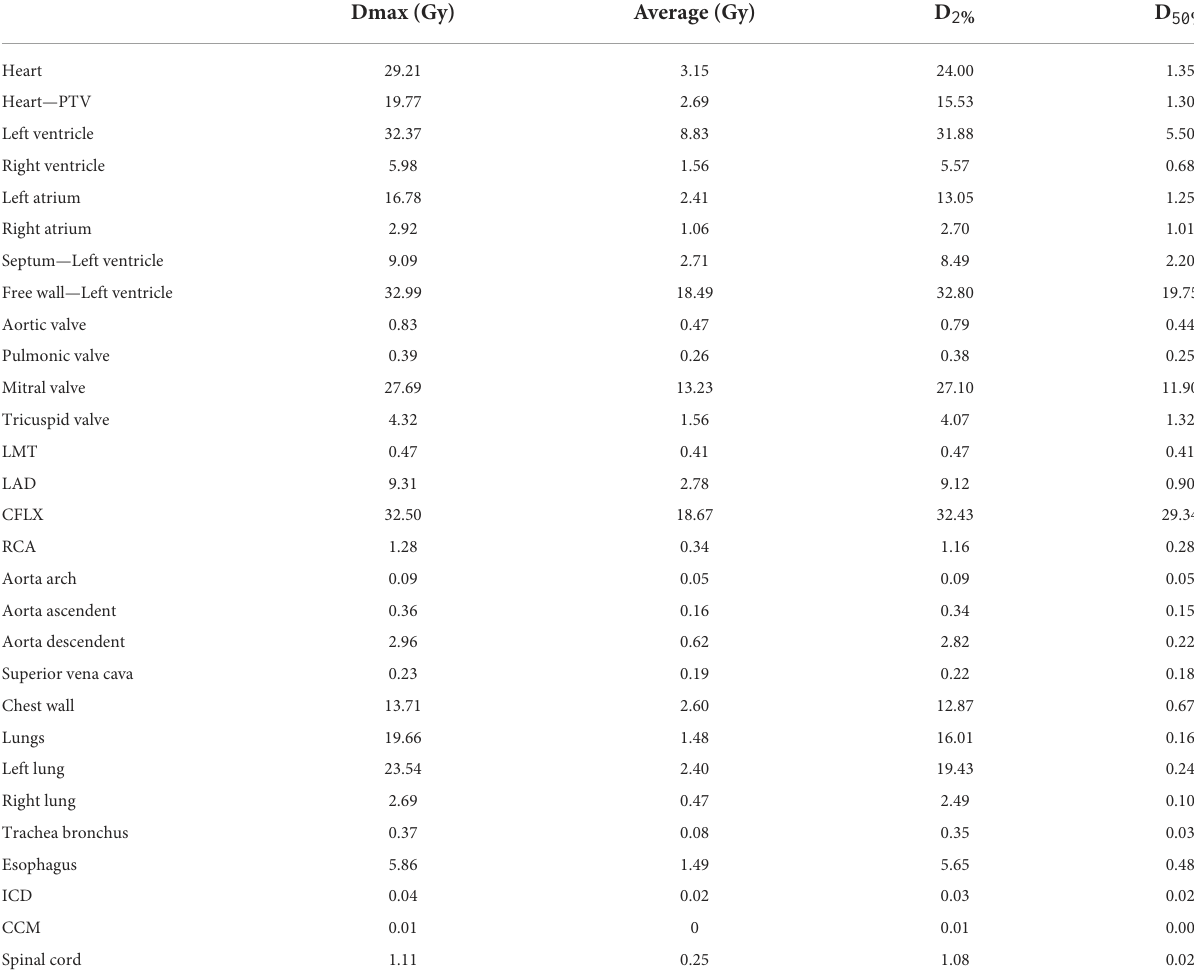
TABLE 1 Dosimetric parameters for organs at risk